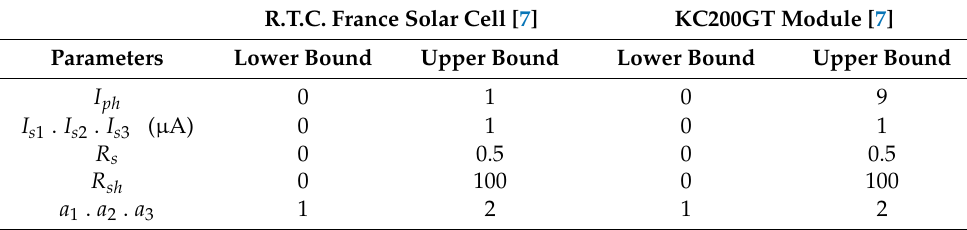
Table 1. The extracted parameters boundaries of test solar cells and